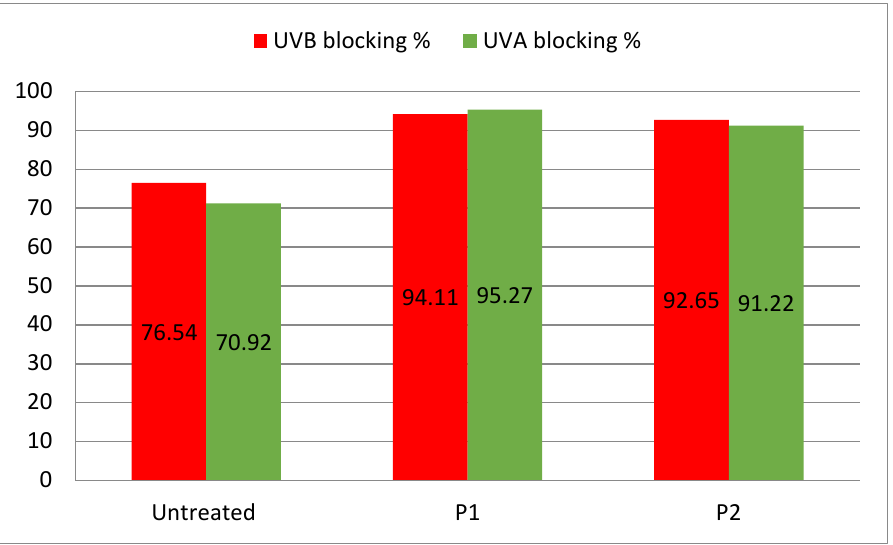
Figure 10. UVA and UVB blocking percentage values of unloaded and ZnO loaded P1 and P2 samples.